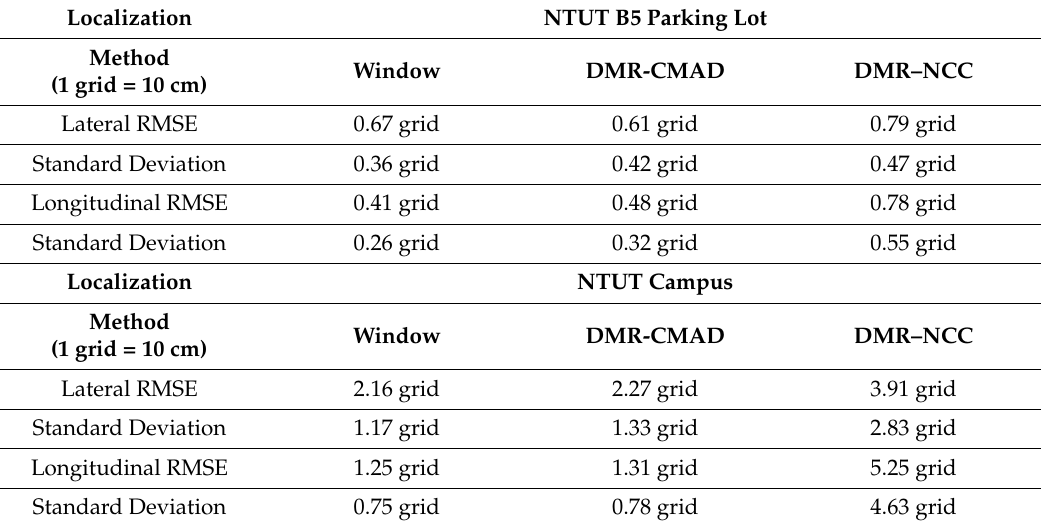
Table 1. Lateral and longitudinal root mean square errors (RMSEs) and standard deviations (SDs) of the Window, DMR–CMAD, and DMR–NCC trajectories.